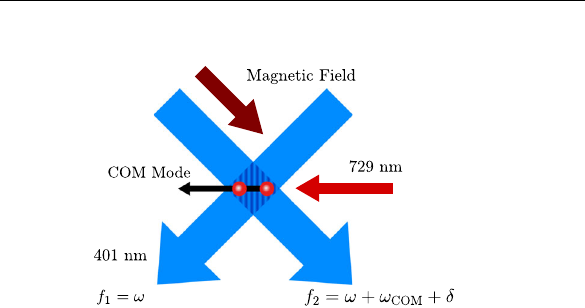
Fig. 1 | Level scheme of the 40 Ca + ion. Encoding quantum information in the sub- levels of the S 1/2 and D 5/2 manifold allows us to increase the size of the computa- tionalHilbertspace.Coherentoperationsbetweenthesub-levelscanbeperformed using729nmlaserlight,while401nmlightisusedtogeneratethelightshiftforthe state-dependent force.